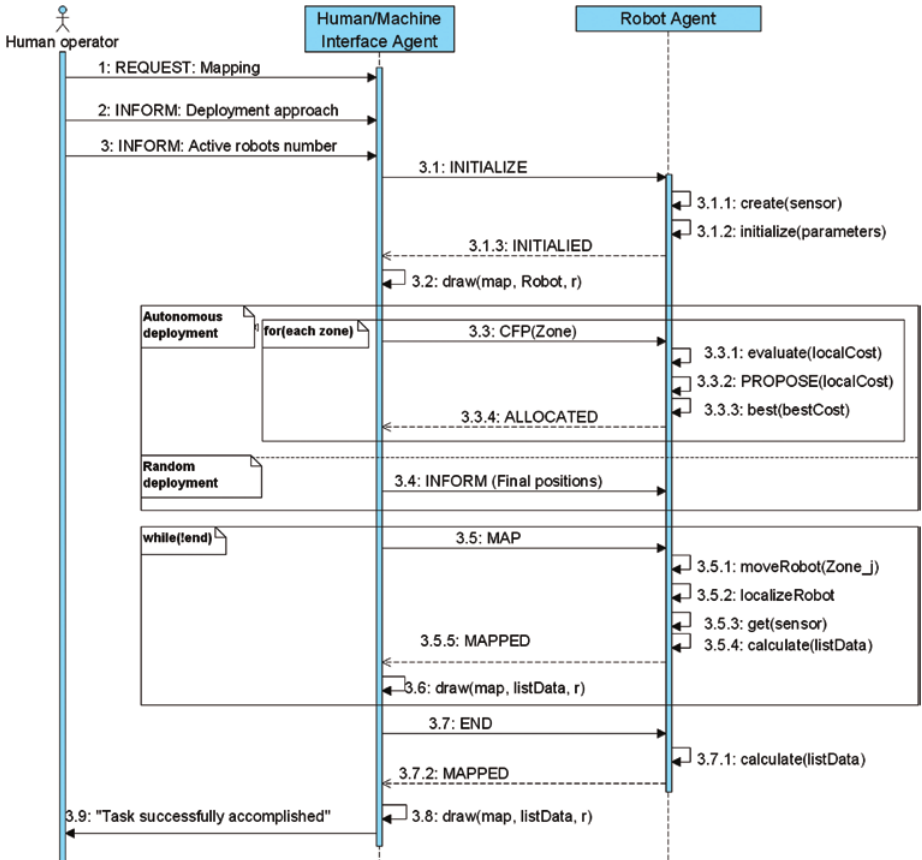
Figure 5: Sequence Diagram for the Whole